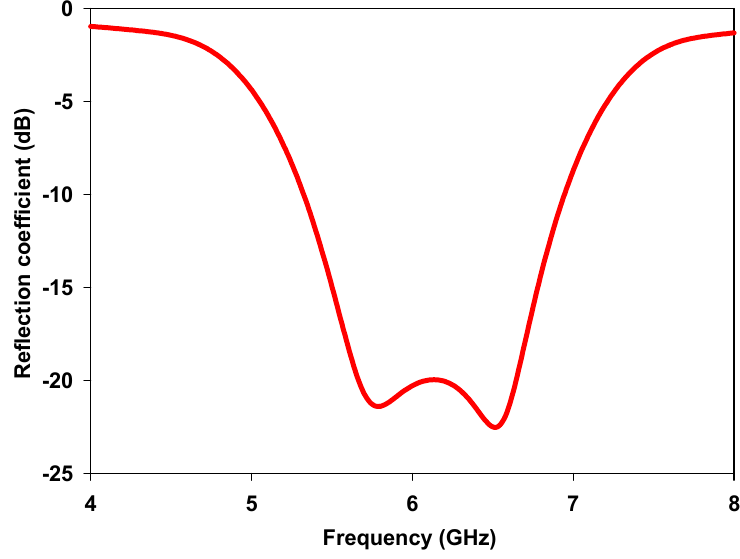
Figure 7. Simulated reflection coefficient S11 (dB).